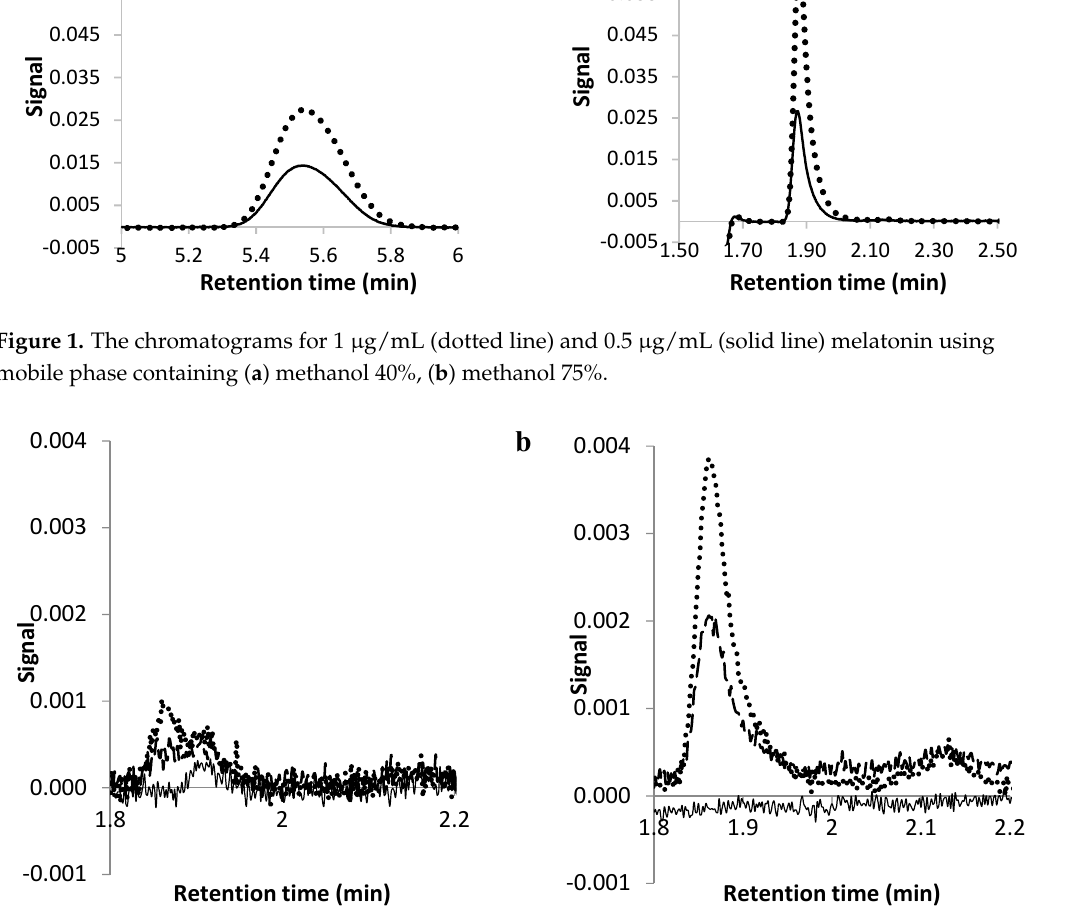
Figure 2. The chromatograms for 0.1 µg/mL (dotted line), 0.05 µg/mL (dashed line) melatonin and baseline 75% methanol (solid line) using UV detection at a wavelength of ( a ) 285 nm ( b ) 228 nm.